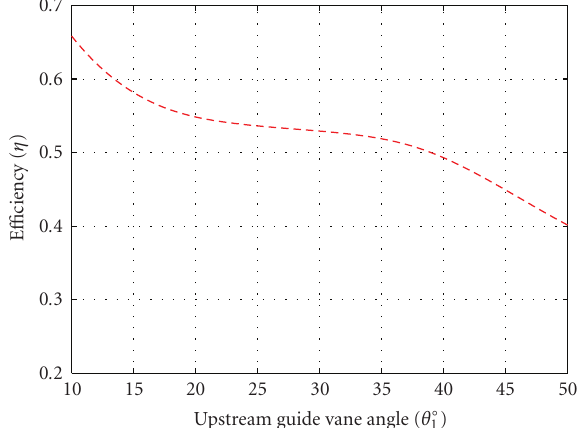
Figure 14: E ffi ciency versus upstream guide vane setting up